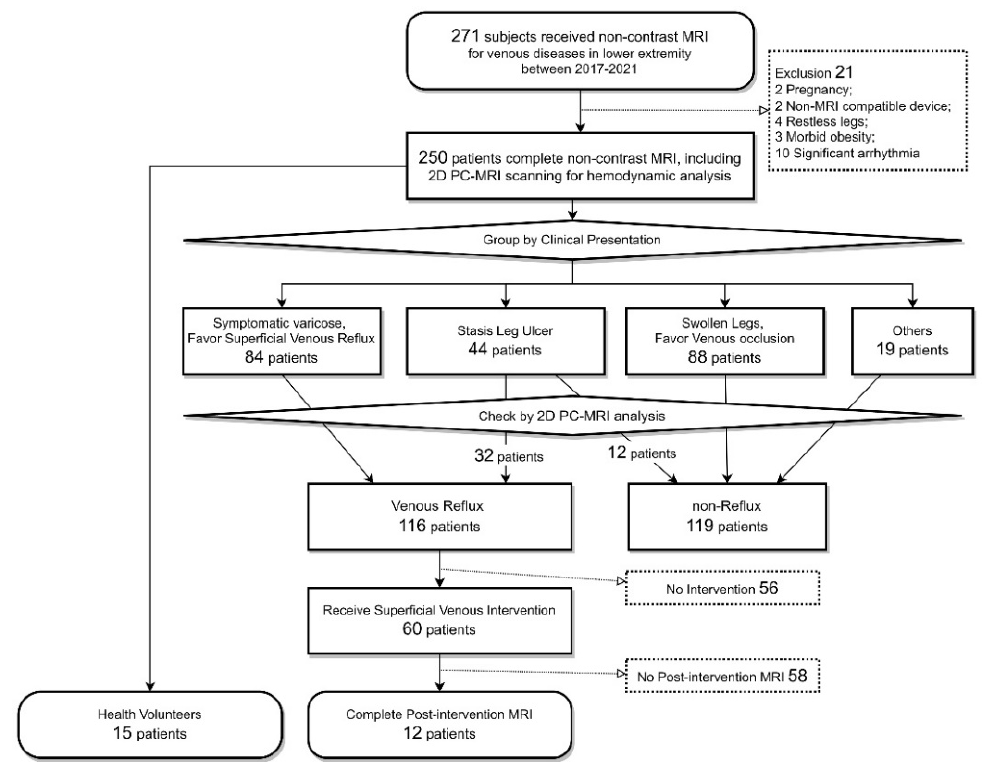
Figure 1. Cohorts of the study.